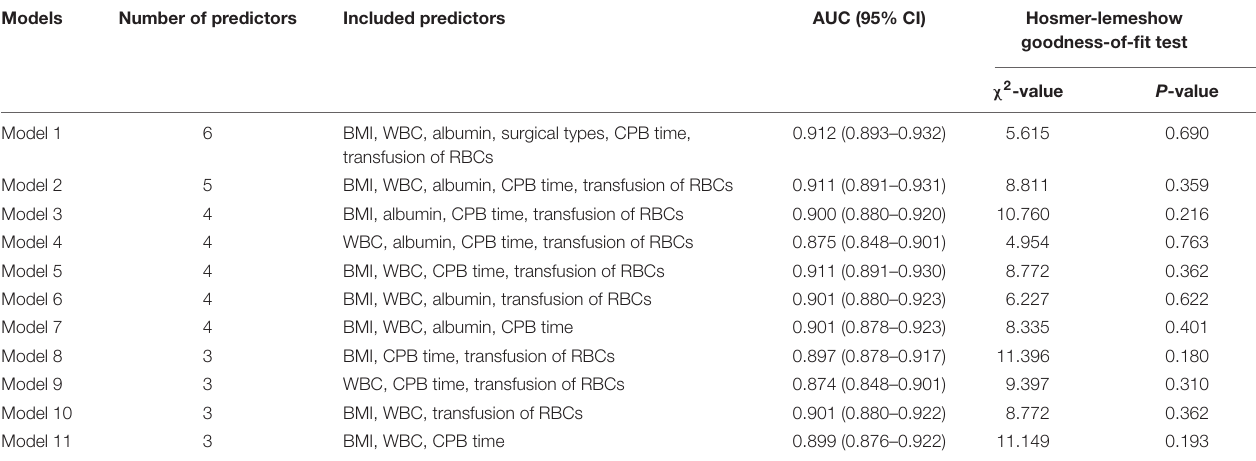
TABLE 2 | Comparison of the multiple logistic regression models for SH after cardiac surgery. Models Number of predictors Included predictors AUC (95% CI) Hosmer-lemeshow